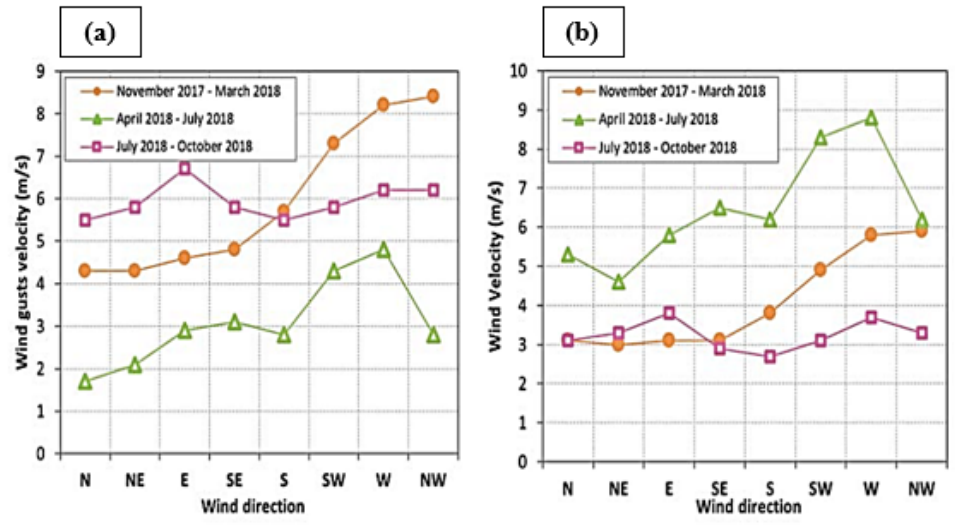
Figure 3. ( a ) Gust velocity; ( b ) wind speed as a function of wind direction of the studied period [13].